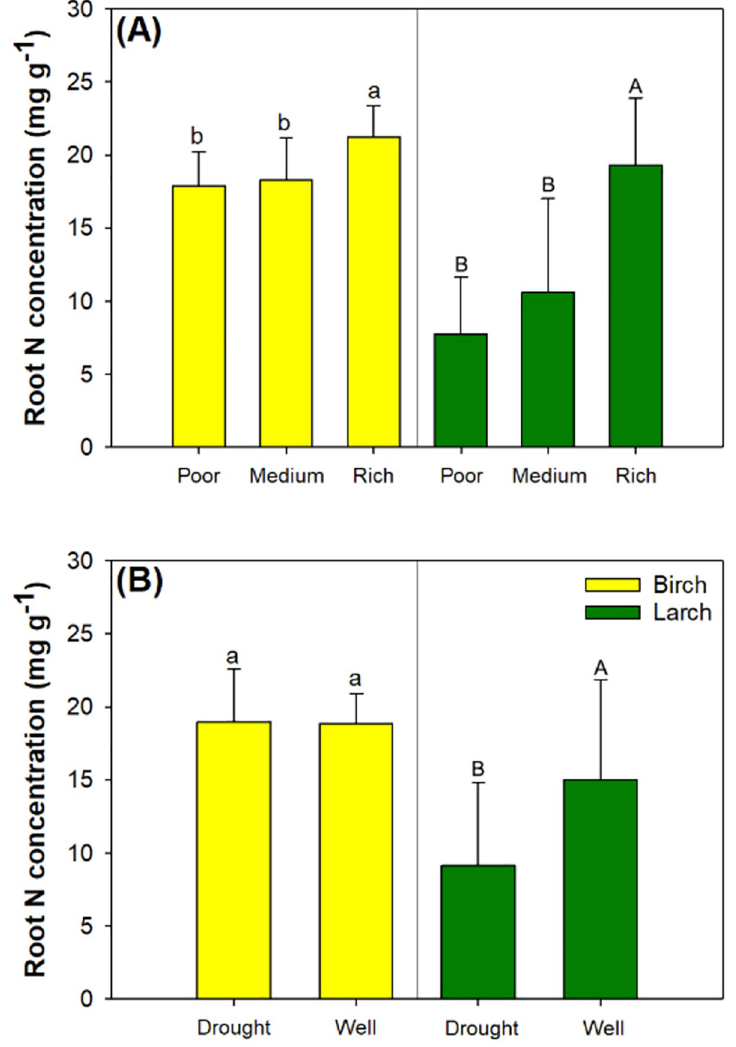
Fig 5. Nitrogen (N) concentration in roots of birch ( Betula Platyphylla ) and larch ( Larix olgensis ) seedlings subjected to heterogeneous or homogeneous nutrient patterns (top) or in drought vs well-watered conditions (bottom). Bars indicate standard deviations. Different letters indicate significant difference of raw transformed data (see S1 Table) according to Duncan test at 0.05 level. Lower case letters stand for differences for birch seedlings and capital letters for larch